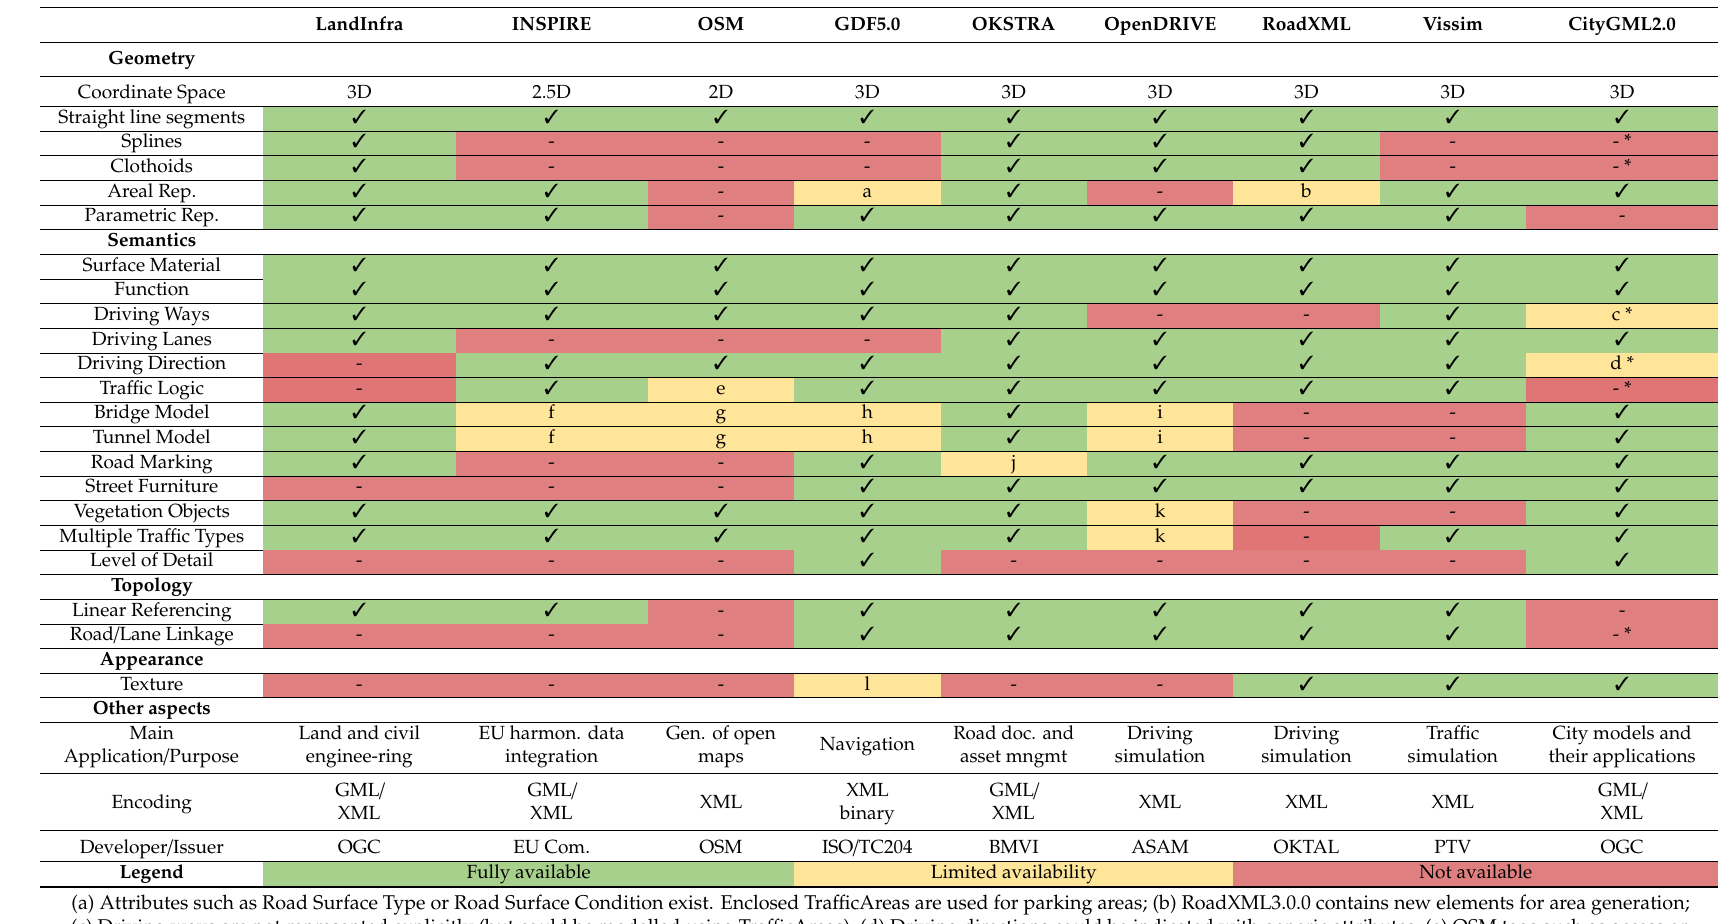
Table 1. Comparison of standards dealing with streetspace modelling ([22] revised and extended). * Additionally available in CityGML3.0 (see Section 5).